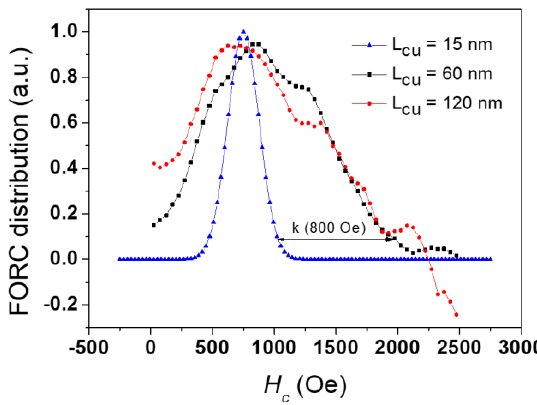
Figure 4. Smoothed and normalized cross sections along the H c axis for Cu thicknesses of 60 (in black) and 120 nm (in red), along with the coercivity distribution estimated from the FORC distribution for 15 nm Cu thickness (in